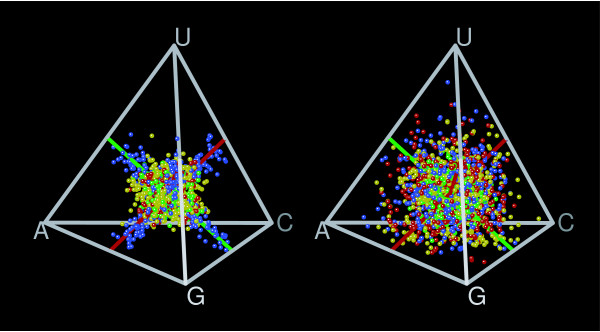
Base composition by codon position for randomized base usages. Left: permuted by positional bases, where the variability at each position is preserved, but the direction of the variability is rotated by 90 degrees around an arbitrary axis. Right: randomly chosen positional bases, where the amount of variability and the size of the correlations between axes at each position are destroyed. First position, yellow; second position, red; third position, blue; and total, green. Compare this figure with biological codon usages in Figure 2.